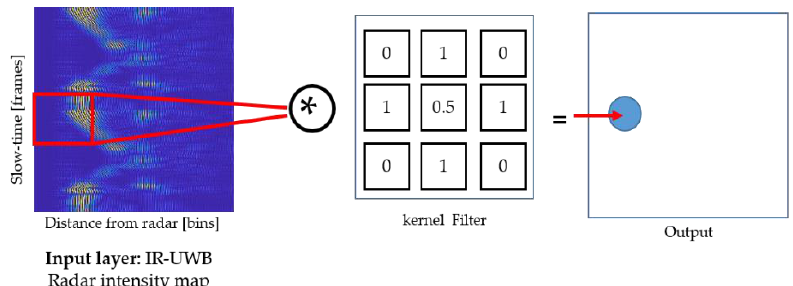
Figure 7. 3D convolutional operation for IR-UWB radar data within one hidden layer.